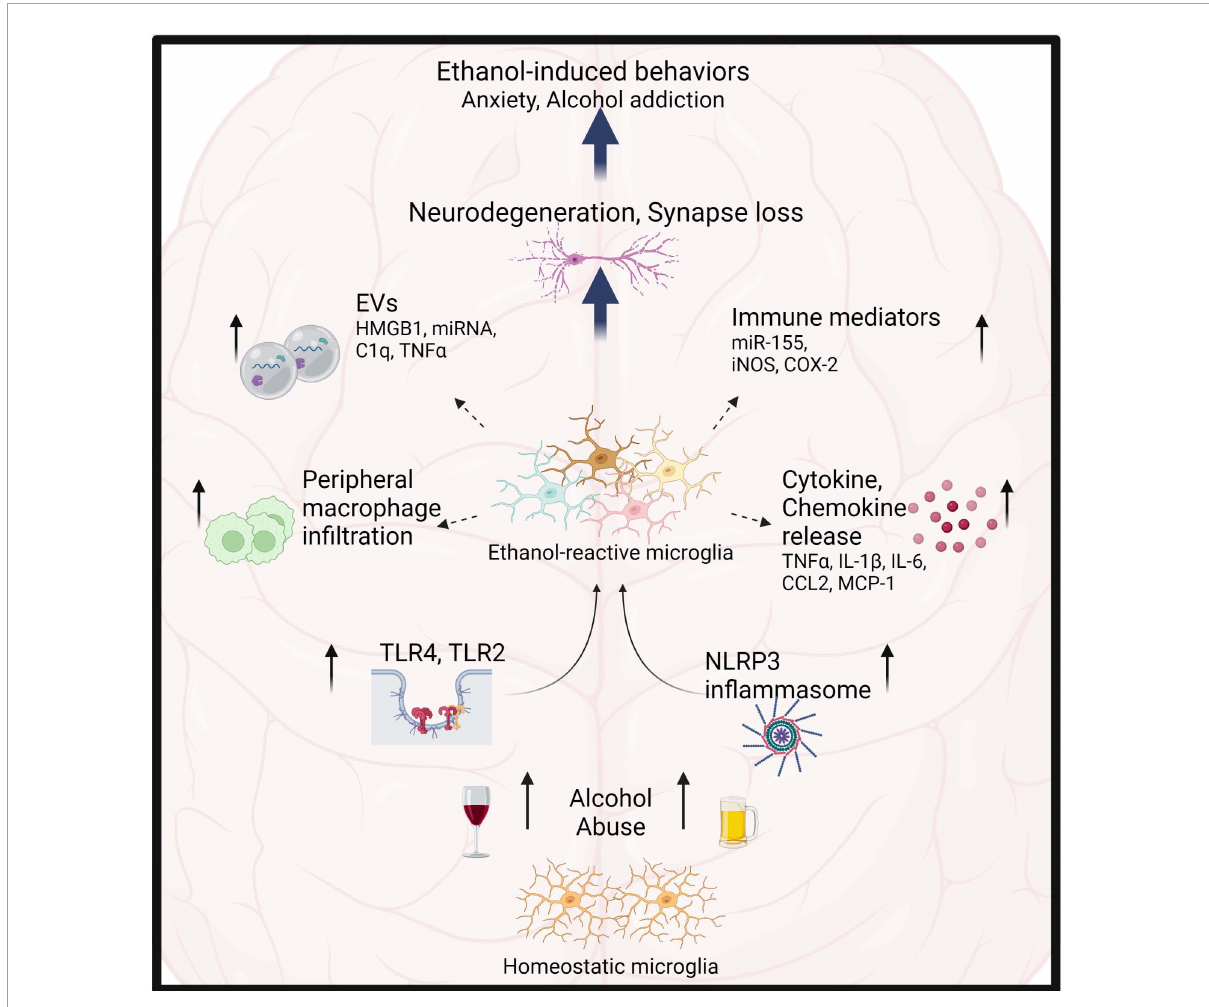
FIGURE1 Microglia play critical role in alcohol-induced neuroinflammation. Alcohol abuse leads to microglia activation primarily through TLR4, 2, and NLRP3 inflammasomes. Consequently, microglia show increased proliferation, morphological transformation, release of cytokines, chemokines, EVs and immune mediators. This results in infiltration of peripheral macrophages, neurotoxicity, synapse loss and modulation of ethanol-induced